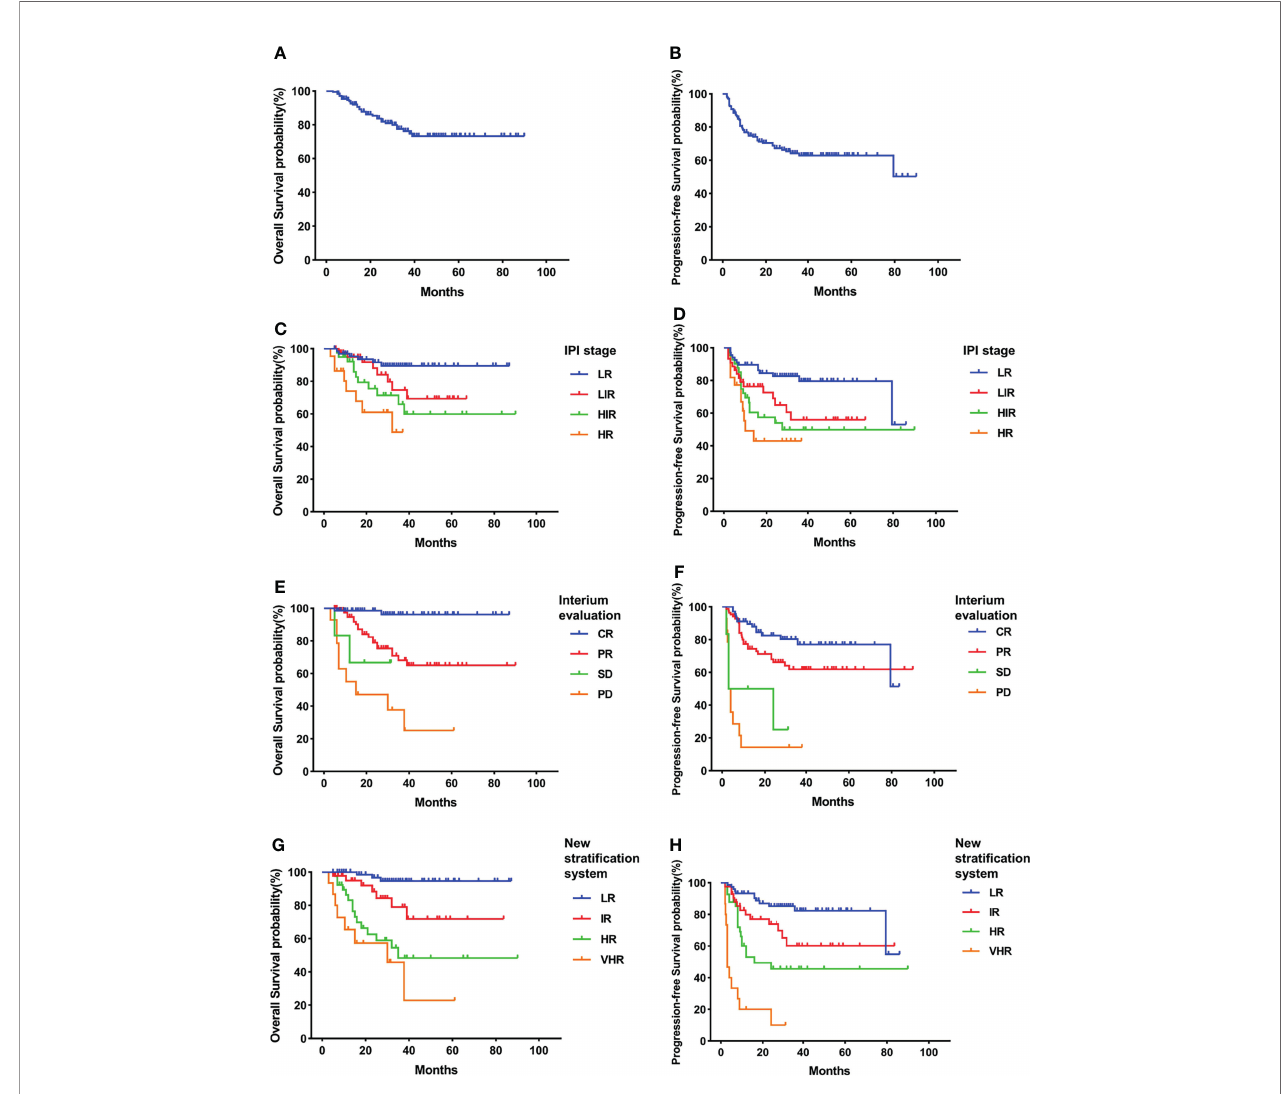
FIGURE 3 | Survival rates of non-germinal center B-cell (non-GCB) subgroup. (A) Overall survival (OS). (B) Progressive-free survival (PFS). (C) OS according to International Prognostic Index (IPI) and interim evaluation. (D) PFS according to IPI and interim evaluation. (E) OS when strati fi ed with interim evaluation. (F) PFS when strati fi ed with interim evaluation. (G) OS according to the new risk strati fi cation system by combination of interim evaluation and IPI. (H) PFS according to the new risk strati fi cation system by combination of interim evaluation and